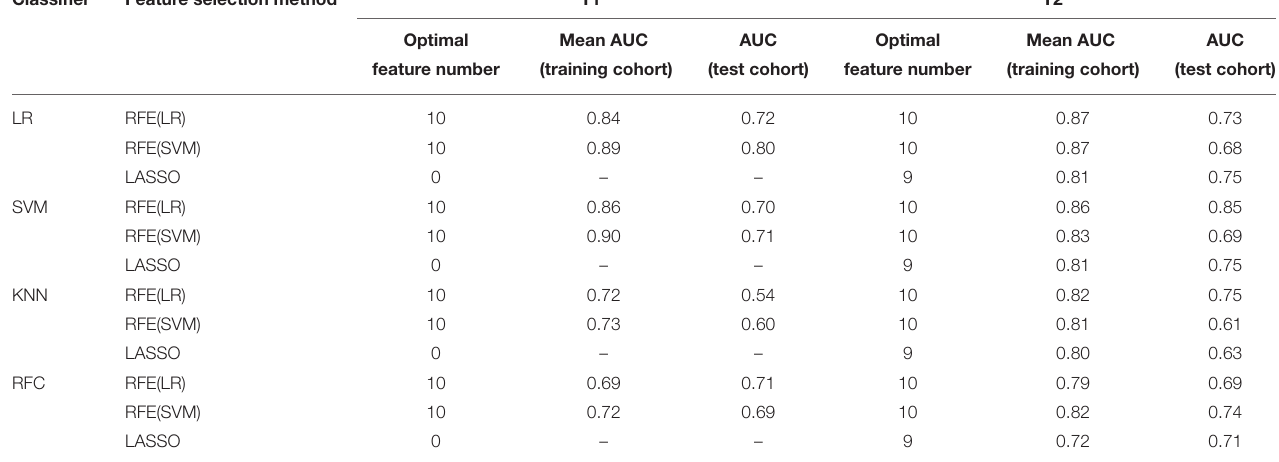
TABLE 3 | DTL model